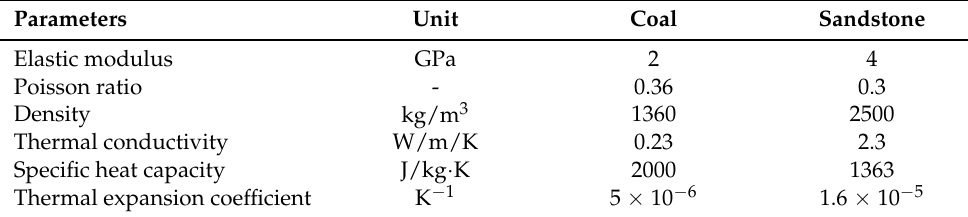
Table 4. Thermal–mechanical parameters of coal and sandstone. Parameters Unit Coal Sandstone Elastic modulus GPa Poisson ratio - Density Thermal conductivity Specific heat capacity Thermal expansion